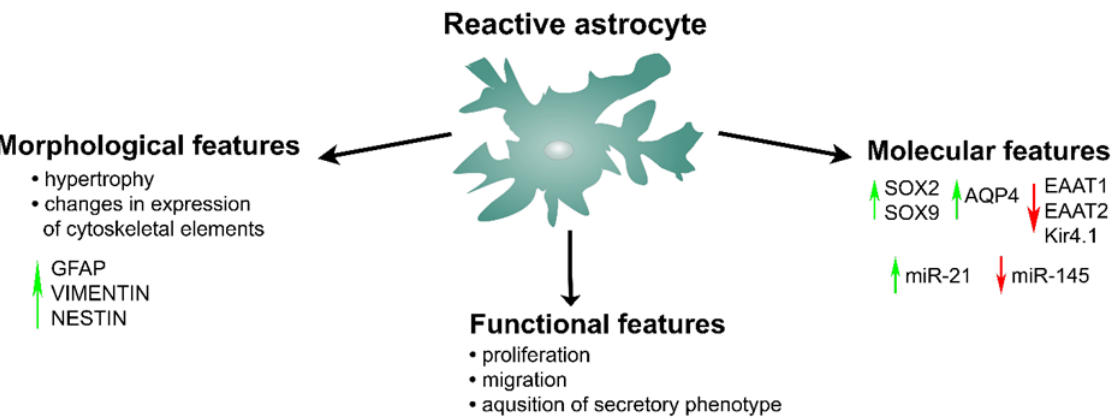
Figure 1. Major morphological, molecular, and functional features of reactivated astrocytes. Reactive astrocytes undergo morphological changes in response to injury, including variable levels of hypertrophy (of cell body and processes) depending on the severity of the injury, as well as the increased expression of intermediate filaments, i.e., glial fibrillary acidic protein (GFAP), VIMENTIN, and NESTIN. In more severe cases of CNS injury, reactive astrocytes proliferate and migrate toward the site of injury where they form a glial scar. They acquire secretory phenotypes with either beneficial or detrimental effects on CNS recovery. Reactive astrocytes go through significant molecular expression changes. They up-regulate neural stem cell-related factors SOX2 and SOX9. They down-regulate astrocytic glutamate transporters, excitatory amino acid transporter 1 and 2 (EAAT1, EAAT2), as well as inwardly rectifying potassium channel 4.1 (Kir4.1) and up-regulate the aquaporin 4 (AQP4) water channel. miR-21 is up-regulated, while miR-145 is down-regulated in reactive astrocytes.